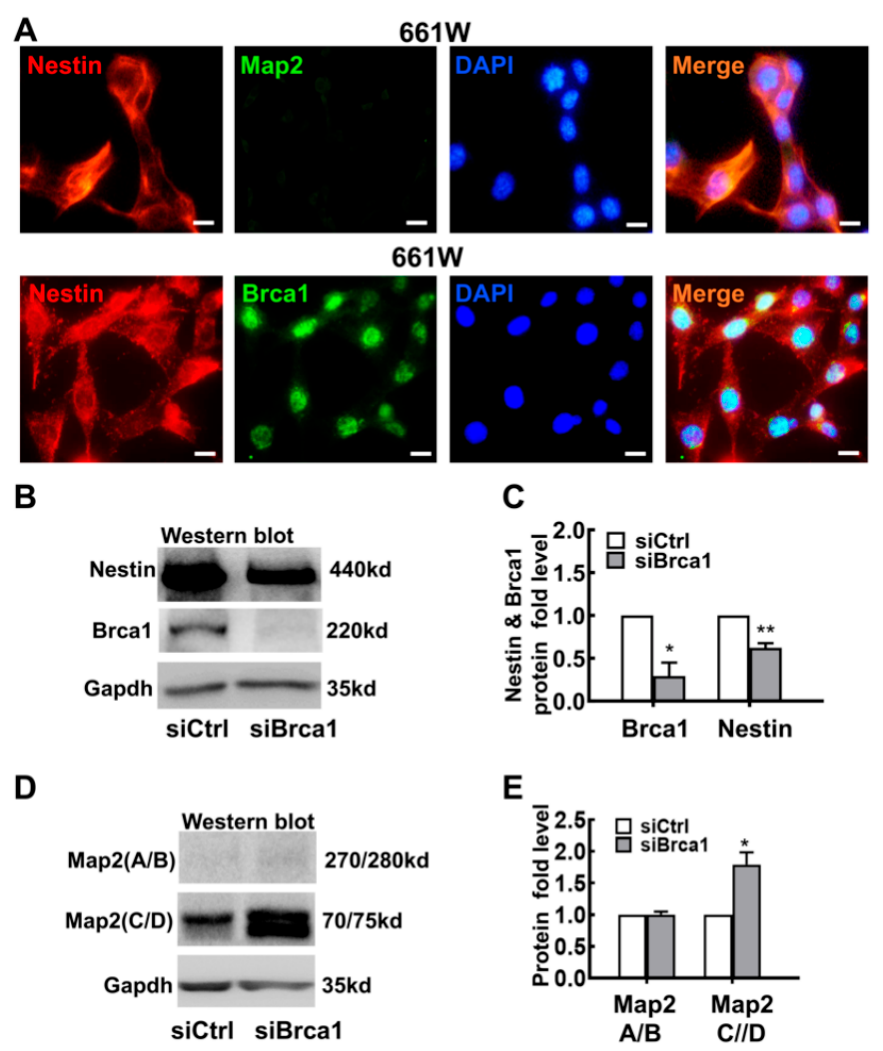
Figure 1. Brca1 silencing induces differentiation of 661W cells. ( A ) Strong Nestin expression (red) and faint Map2 expression were observed in the cell cytoplasm of 661W cells. Brca1 was expressed at high levels in the cellular nuclei of 661W cells (green). The nuclei were stained with DAPI (blue). ( B ) Nestin expression was decreased in Brca1 -silenced 661W cells, as evidenced by Western blot. ( C ) The relative expression levels of Nestin and Brca1 in 661W cells are presented as a histogram. ( D ) Brca1 silencing significantly increased the expression of Map2 (C/D) in 661W cells. ( E ) The relative protein expression levels of Map2 (A/B) and Map2 (C/D) are presented as histograms. Scale bars represent 10 μ m. The asterisks indicate statistically significant differences (* p < 0.05, ** p < 0.01).